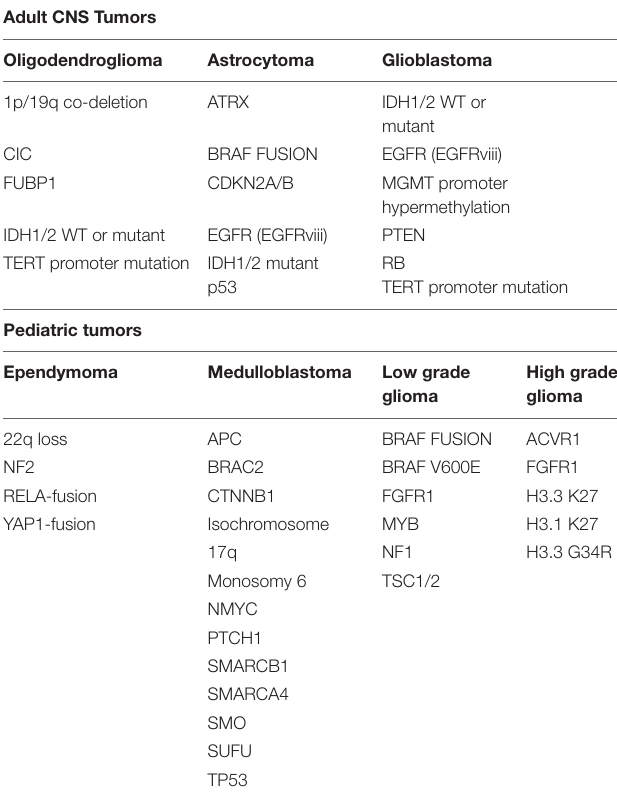
TABLE 1 | Genetic alterations occurring in pediatric and adult brain